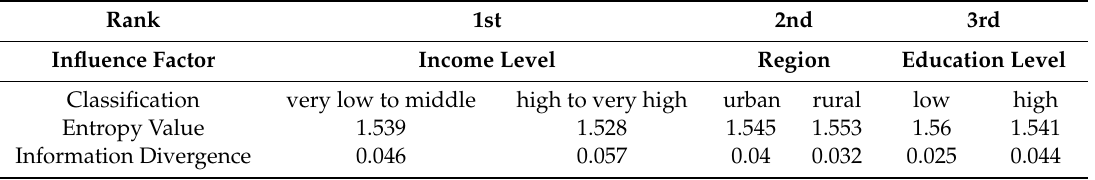
Table 3. Top three distinguishable factors for ecological footprint consumption. Rank